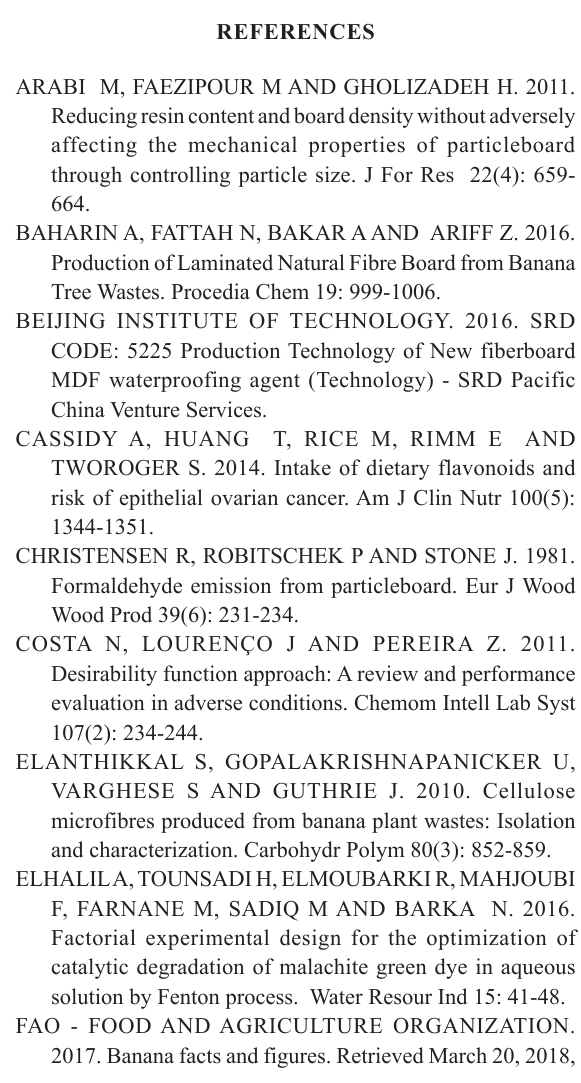
Figure 4 - Optimization of global